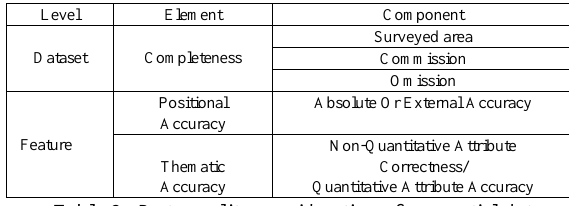
Table 2. Data quality consideration of geospatial data